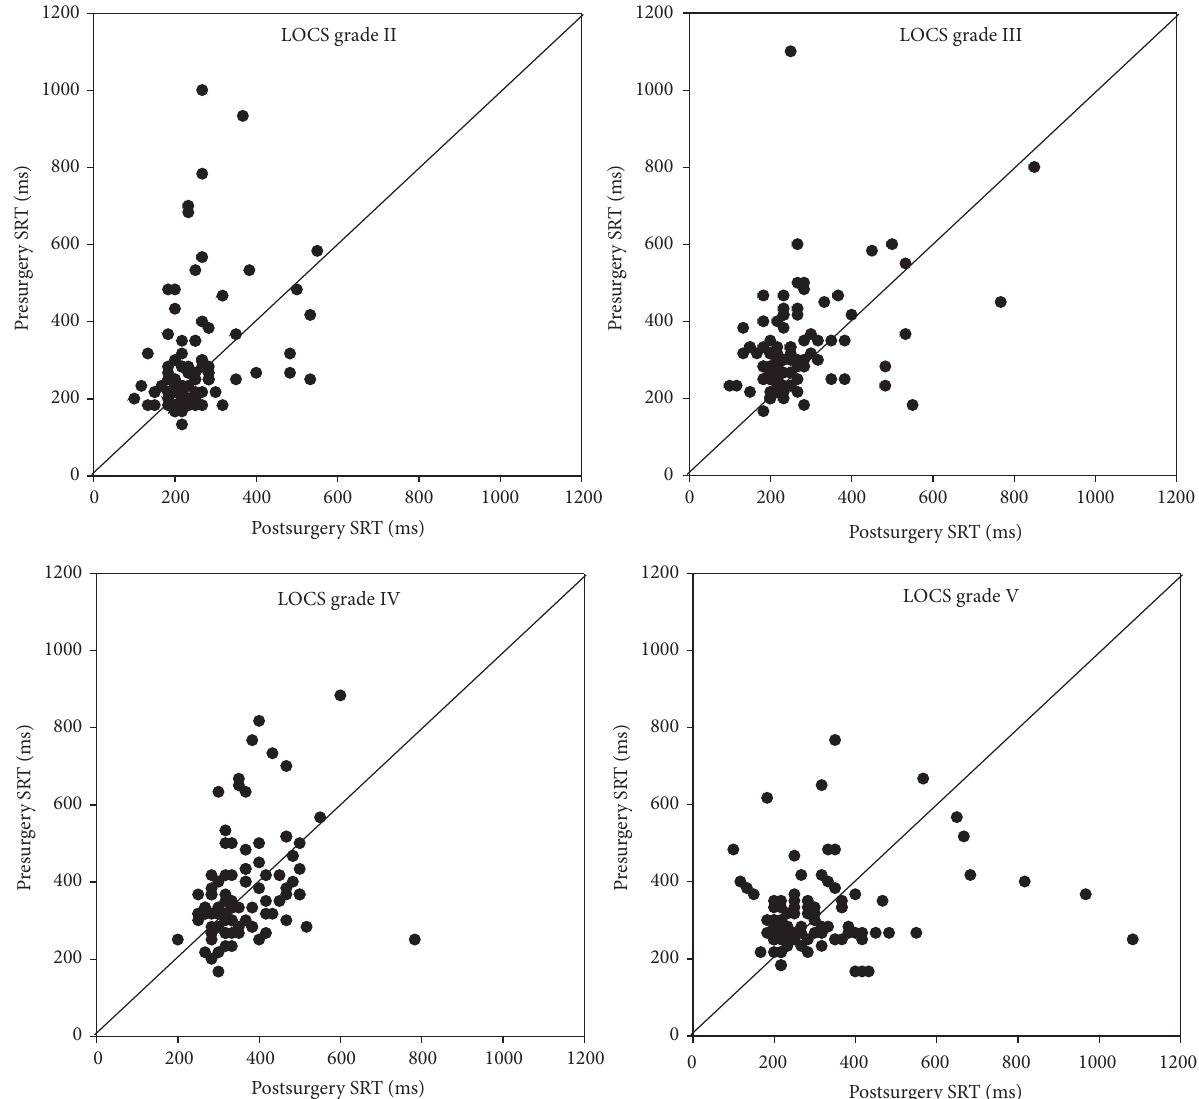
Figure 3: Scatterplots showing pre- versus postsurgery SRT values (ms) assessed in the same eye (108 stimuli) of four patients with different cataract severity (LOCS III grades II through V).